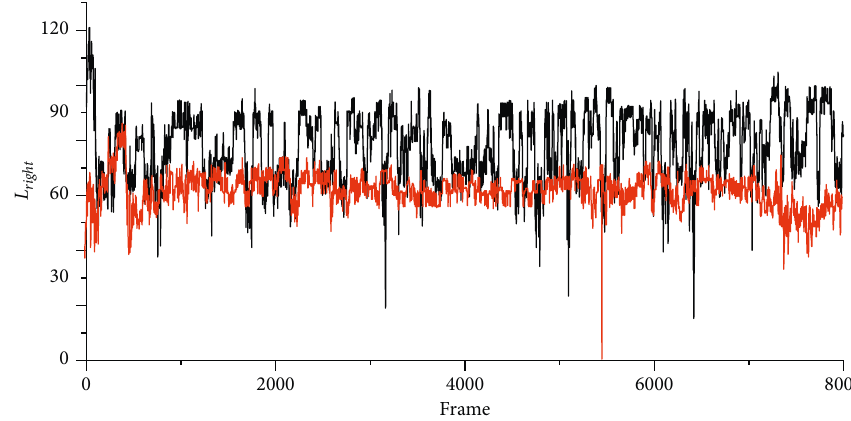
Figure 11: Comparison of the Euclidean distance of right arm in fatigue and normal state.